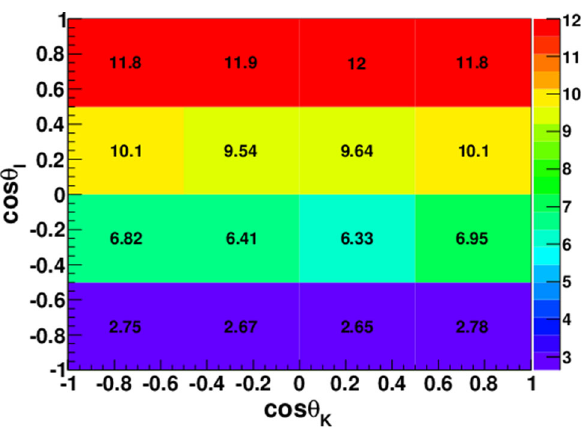
Fig. 4 The signal reconstruction efficiencies (in percentage) in bins of cos θ K and cos θ l . In each bin j , the signal reconstruction efficiency is (cid:3) i (cid:15) ij = i B ST DT (cid:3) , where the B i obtained by (cid:15) j DT i i B ST represents the DT efficiency in each bin j of each tag mode i , the (cid:15) ij DT for tag mode i